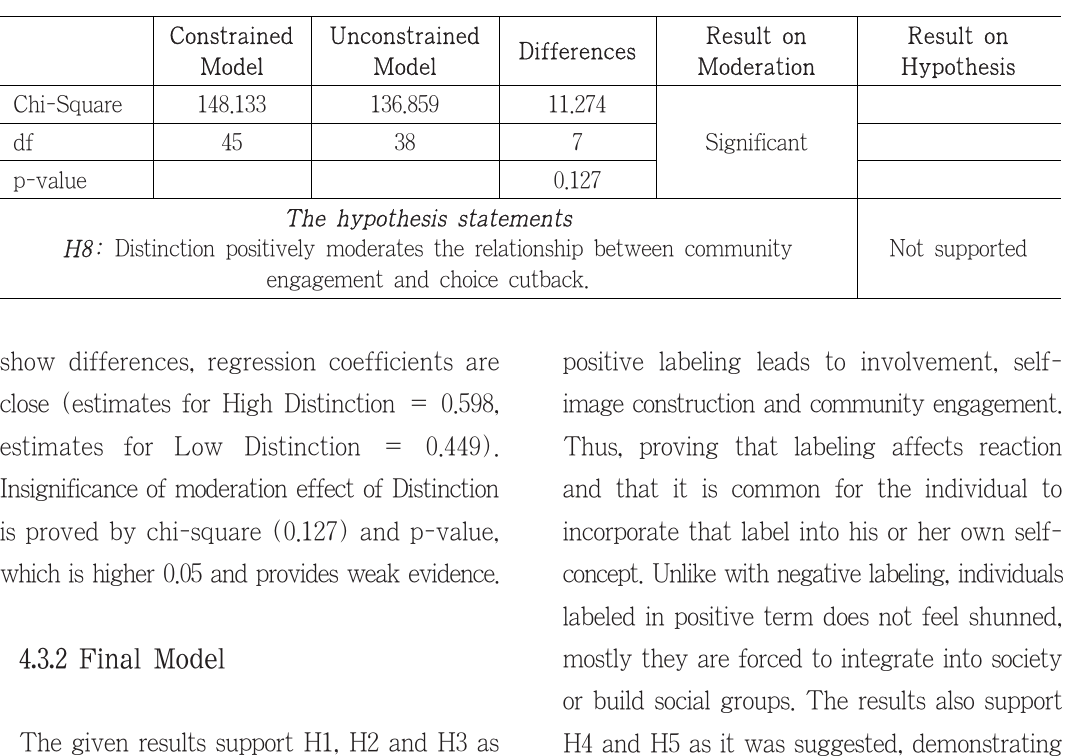
<Table 8> Testing moderating effect of Distinction on Community * Choice